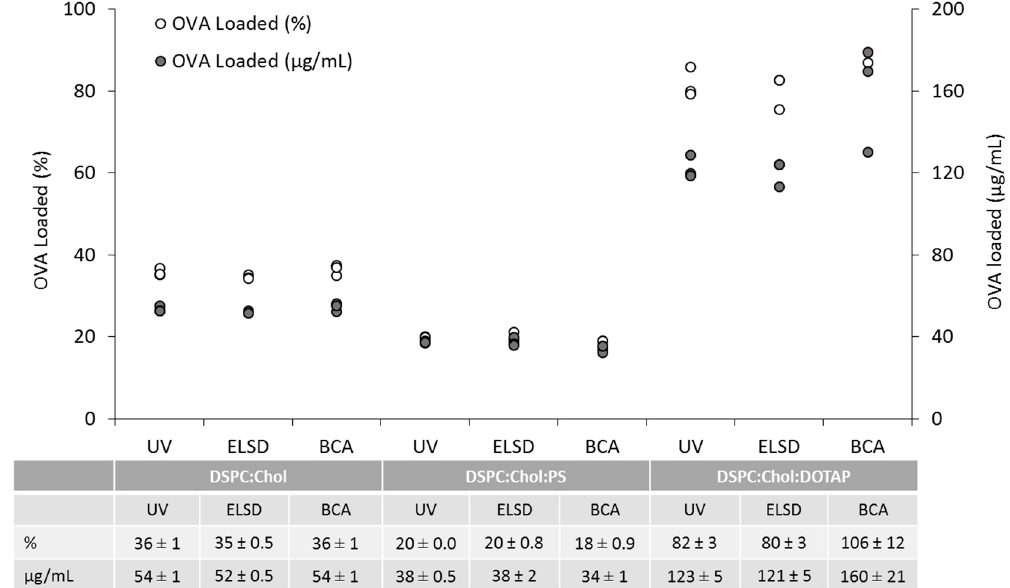
Figure 5. Comparative study between three protein quantification techniques, RP-HPLC, HPLC-ELSD and BCA assay. All three liposomal formulations were made using microfluidics. The DSPC:Chol and DSPC:Chol:PS formulations were made at a 3:1 FRR and 15 mL/min TFR (4 mg/mL initial lipid and 0.25 mg/mL initial ovalbumin concentration). The DSPC:Chol:DOTAP formulation was produced at a 1:1 FRR, and the ovalbumin was adsorbed onto the surface by passing pre-made DSPC:Chol:DOTAP formulation through the microfluidics NanoAssemblr. All results were measured three times, with the average encapsulation and ovalbumin loading calculated.